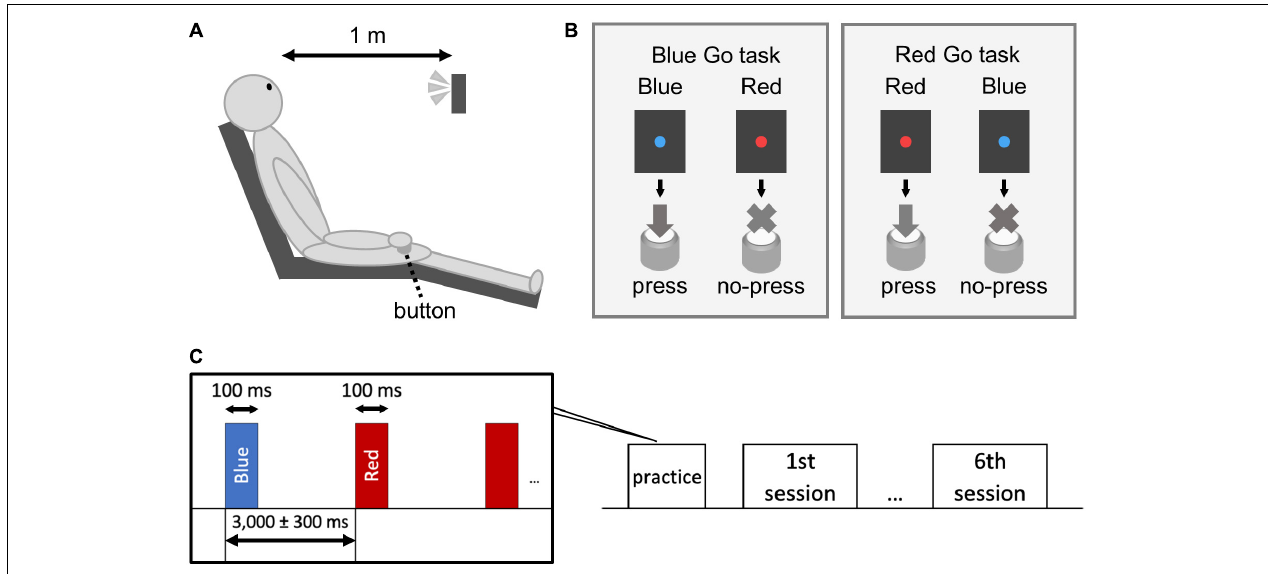
FIGURE 1 | Schematic illustration of the experiment. The subject sat on a chair and performed a Go/No-go task with the right hand (A) . We set up a Blue Go/Red No-go task and a Red Go/Blue No-go task (B) . The target/non-target signal was presented for 100 ms with an interstimulus interval of 3,000 ± 300 ms (C) .